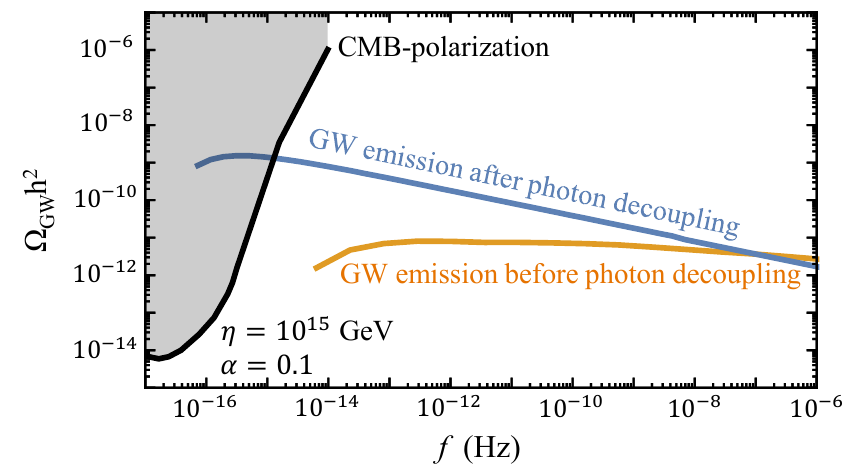
Figure 8 . GW spectrum from a global string network decomposed into contributions from before and after photon decoupling, which demonstrates how CMB polarization constraint is safely evaded (see main text for details). In the example shown, η = 10 15 GeV ( Gµ = 10 − 11